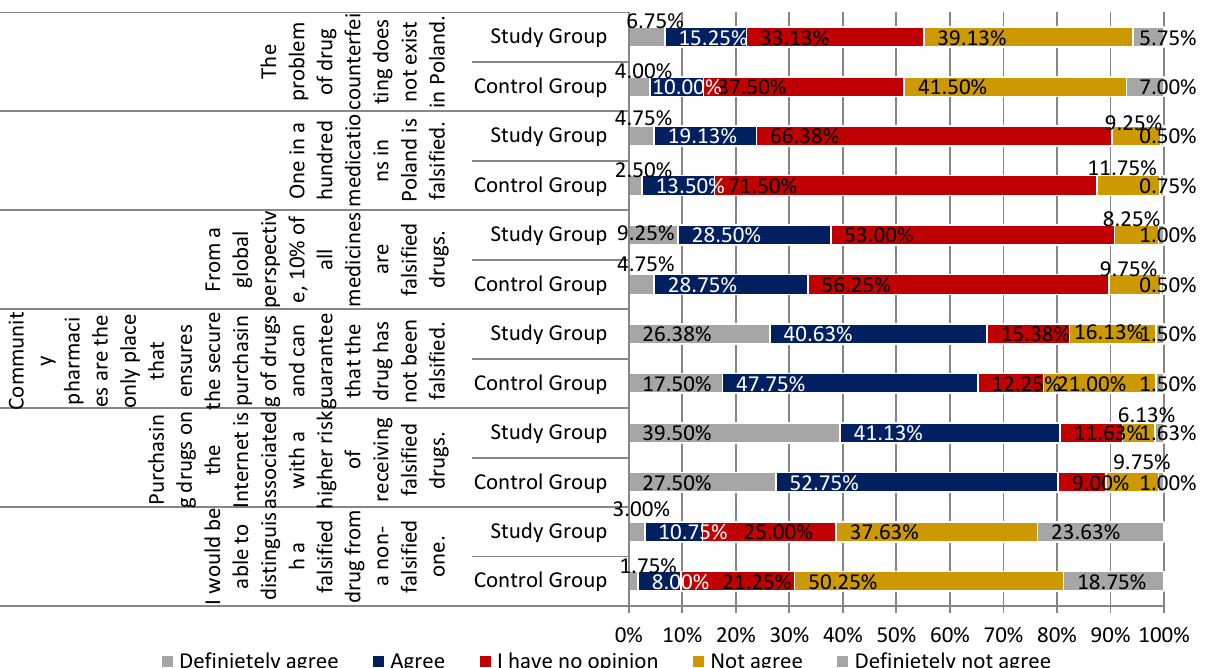
Figure 7. Falsified drugs in the opinion of respondents from the study and control group part 3. Respondents from both groups agreed with the statement that the most commonly falsified drugs are those accelerating weight loss. A larger percentage of people convinced